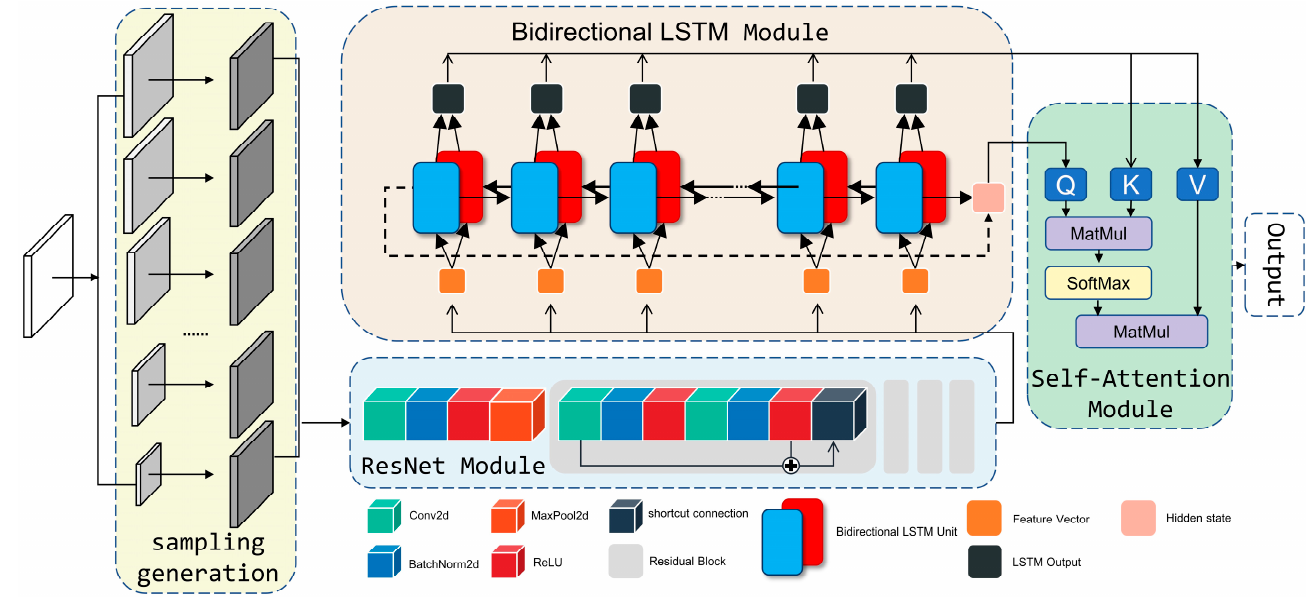
Figure 1. The framework of concentric sequential virtual scenes (SVS).